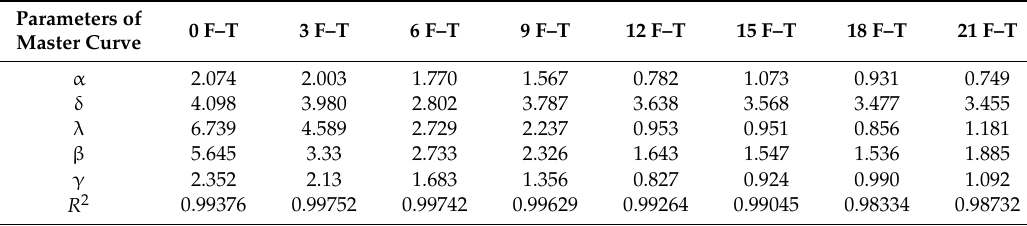
Figure 6. Master curves of dynamic modulus under various freeze–thaw (F–T) cycles (reference temperature = 20 °C). Table 7. Parameters of master curve functions of dynamic modulus under various F–T cycles.